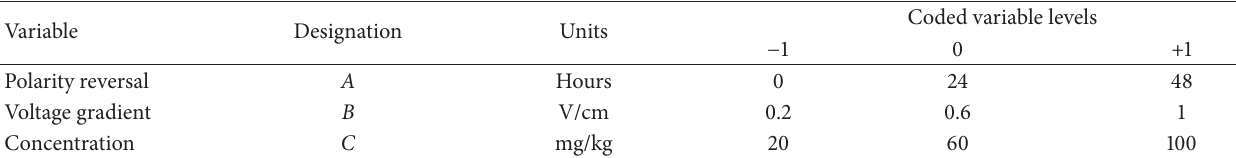
Table 1: Information on the independent variables.